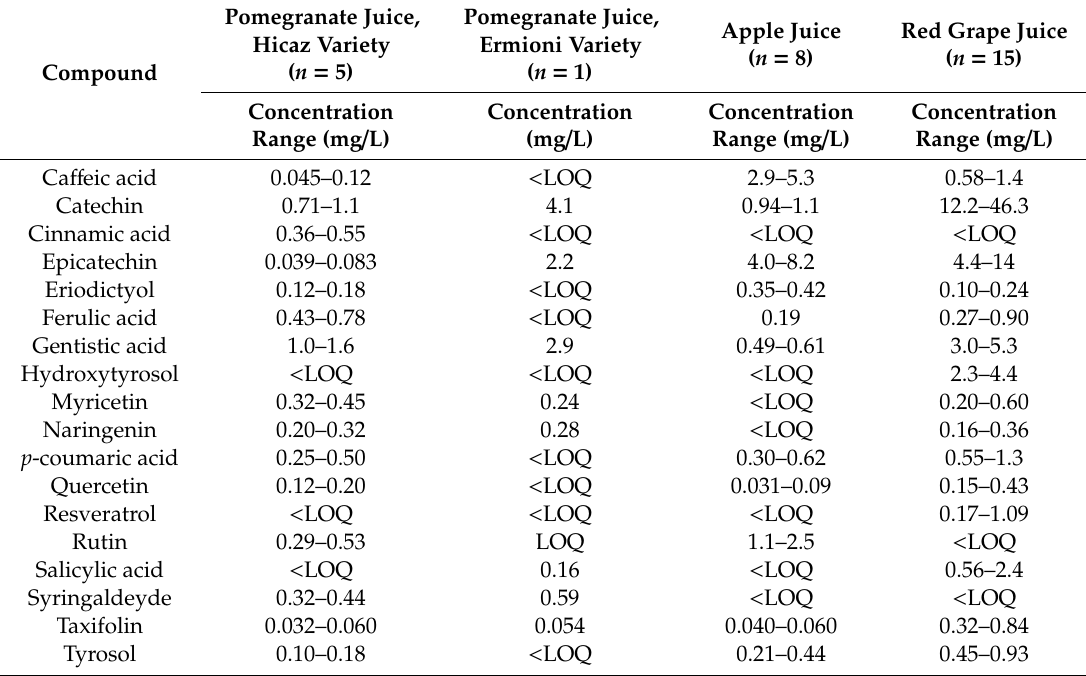
Table 2. Concentrations of phenolic compounds in pure pomegranate, apple, and red grape juices. LOQ: Limit of